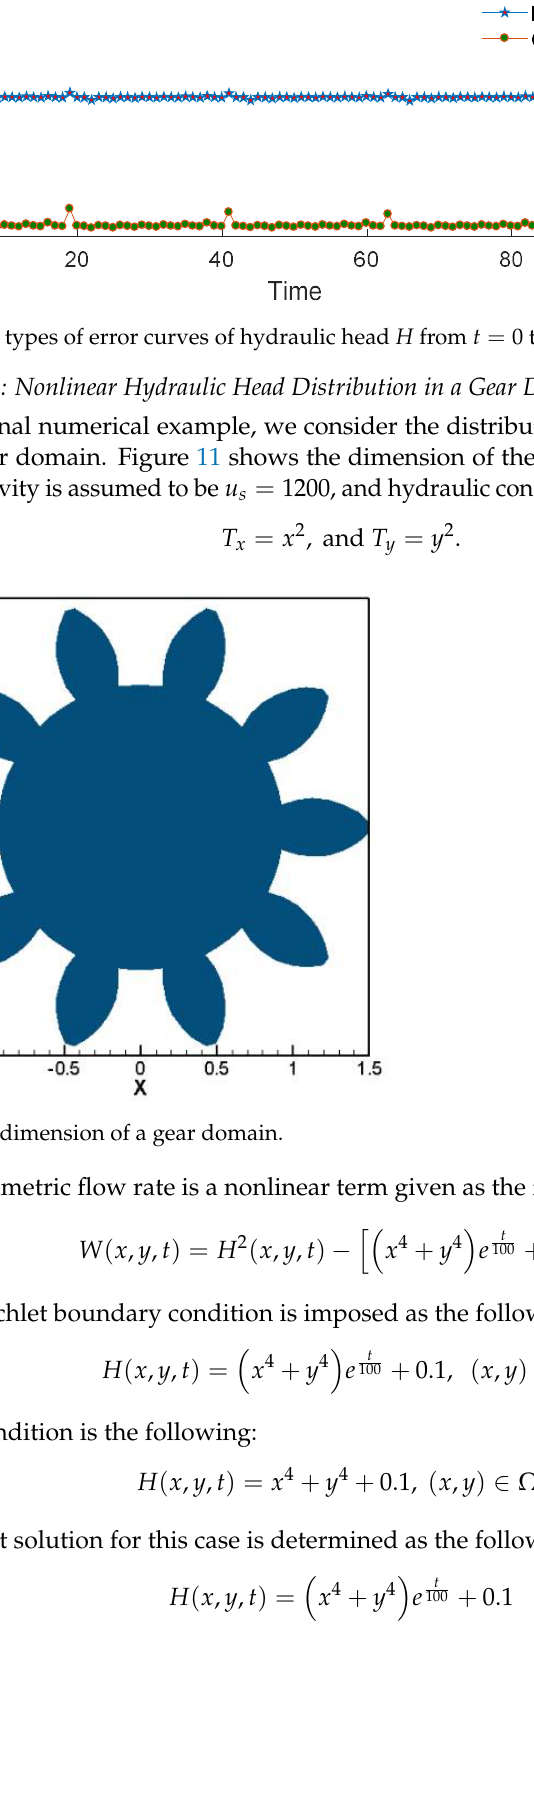
Figure 11. The dimension of a gear domain. The numerical simulation for this case is run from 0 t  to 10 t  . The time step size is set to 0.05 t   , and 1186 collocation nodes are distributed in the gear domain